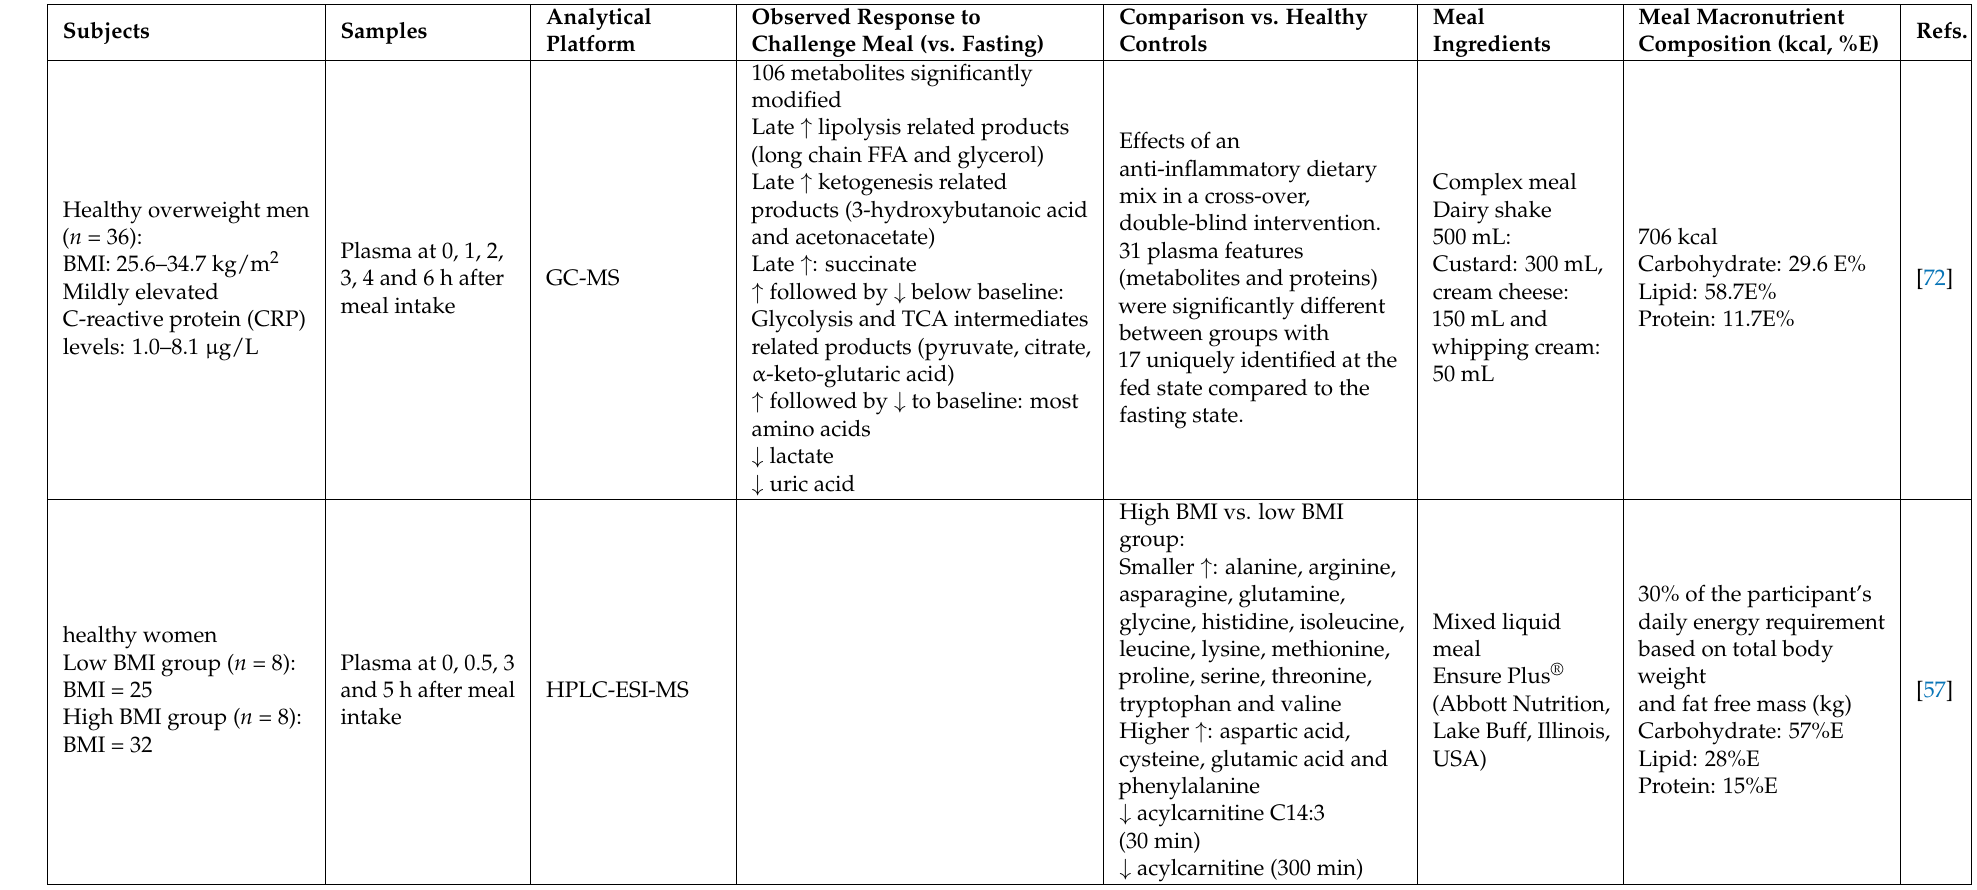
Table 3. Summary of reviewed studies investigating mixed meal response in populations with pre- or pathological conditions, with a metabolomics